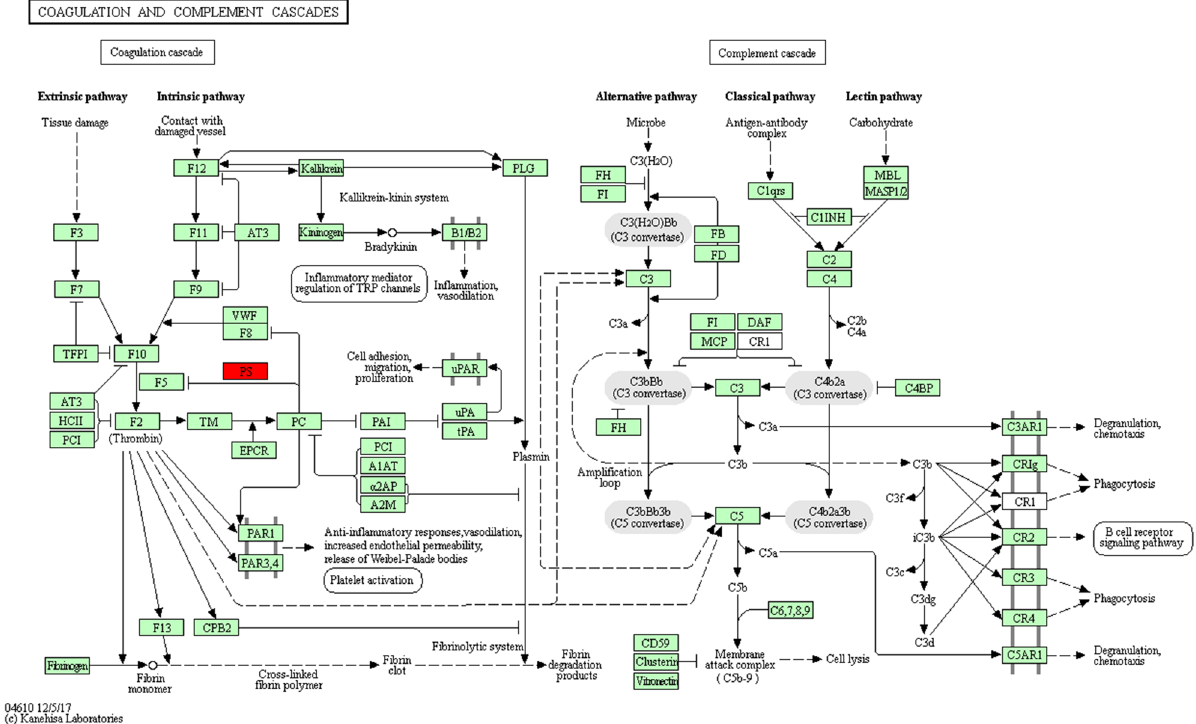
Figure 6. Network pathway of identified plasma proteins in the complement and coagulation cascades that were differentially abundant in CMS. Red and green squares denote proteins increased and decreased, respectively 36